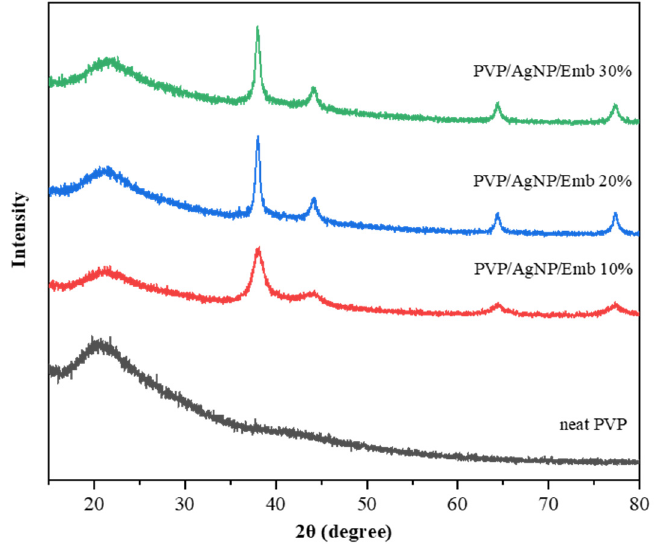
Figure 3. X-ray diffraction patterns of spray-on dressing films loaded with different amounts of Phyllanthus emblica extract and pure PVP Phyllanthus emblica extract and pure PVP film.